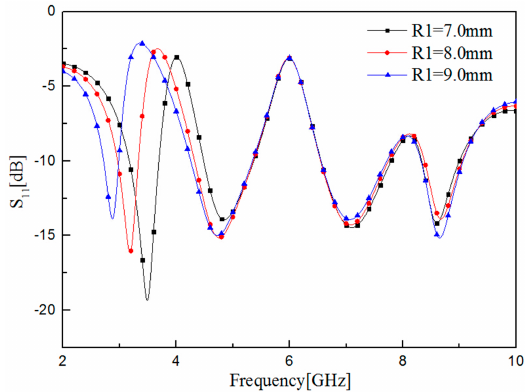
Figure 5. Effect of parameter R 1 on the simulated return loss.